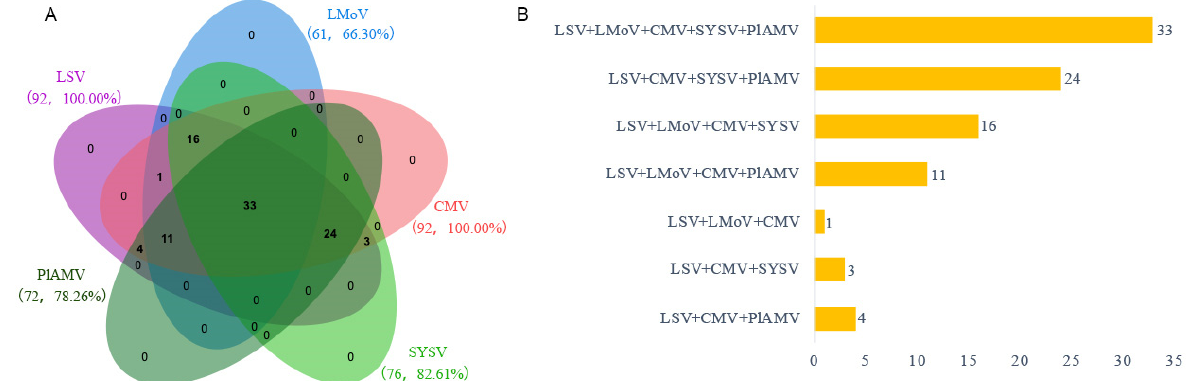
Figure 8. Detection of five viruses in lily plants in China using multiplex TaqMan real-time PCR assay. ( A ) Venn diagram illustrating the number of samples infected by multiplex TaqMan real-time PCR assay. ( B ) Number of samples infected with different viruses.